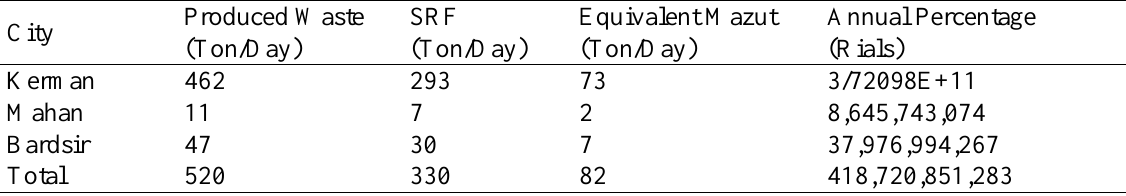
Table 6 . Saving Potentiality of Rial in Alternative SRFs Consumption in Kerman’s Cement